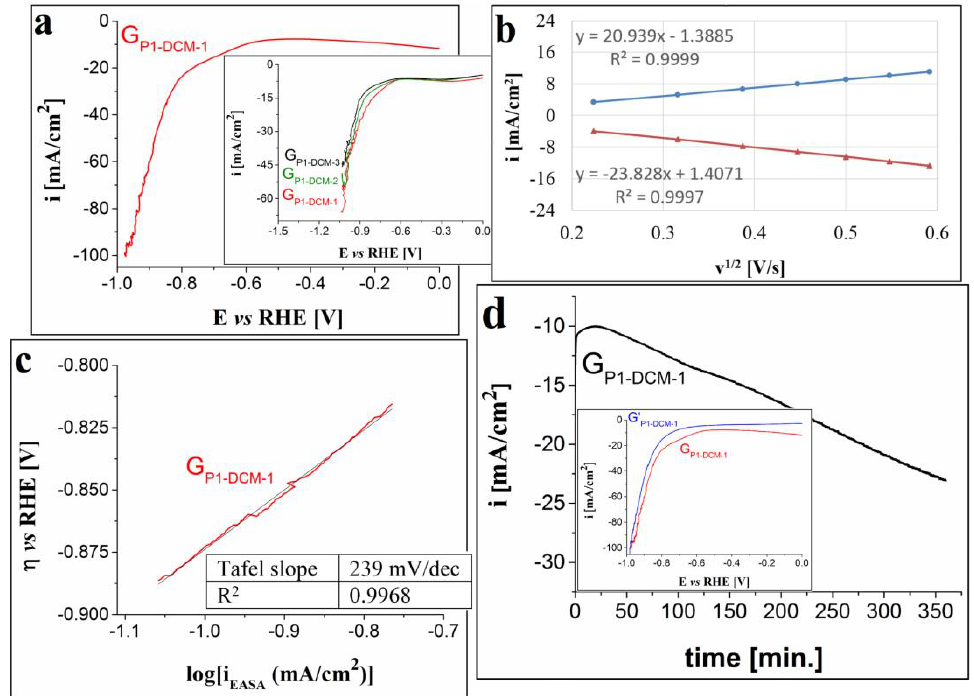
Figure 6. ( a ) Cathodic LSV recorded on the G P1-DCM-1 electrode in 1 M KOH solution, at v = 5 mV/s. Inset shows the voltammograms traced on the G P1-DCM-1 , G P1-DCM-2 and G P1-DCM-3 electrodes in 0.1 M KOH solution. ( b ) The plot of the anodic and cathodic peak current densities vs. the square root of the scan rate for the G P1-DCM-1 electrode. ( c ) The Tafel plot obtained for the G P1-DCM-1 electrode in 1 M KOH solution. ( d ) i-time curve recorded on the G P3-DCM-1 electrode in 1 M KOH solution and inset showing the LSVs traced on the electrode before and after the stability test (coded as G P1-DCM-1 and G’ P1-DCM-1